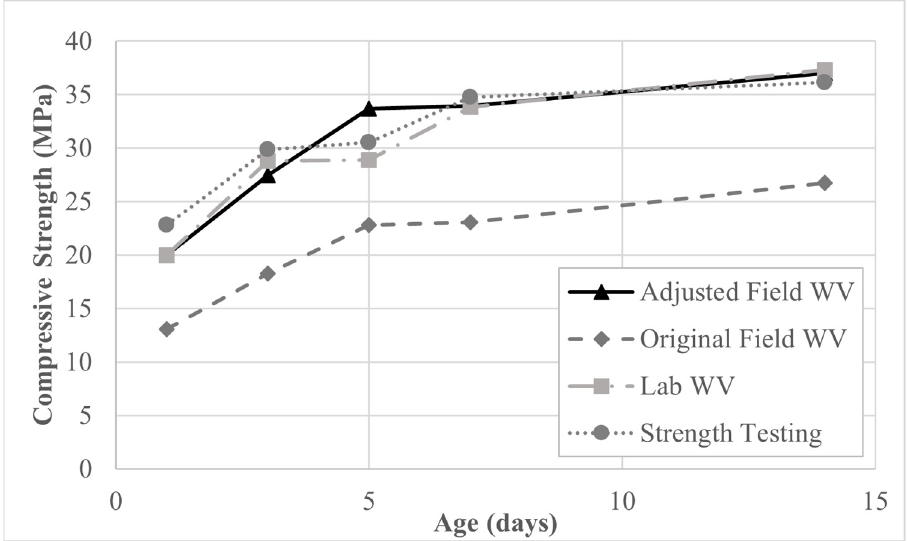
Figure 3. Differences between beam and slab velocities before and after shifting.